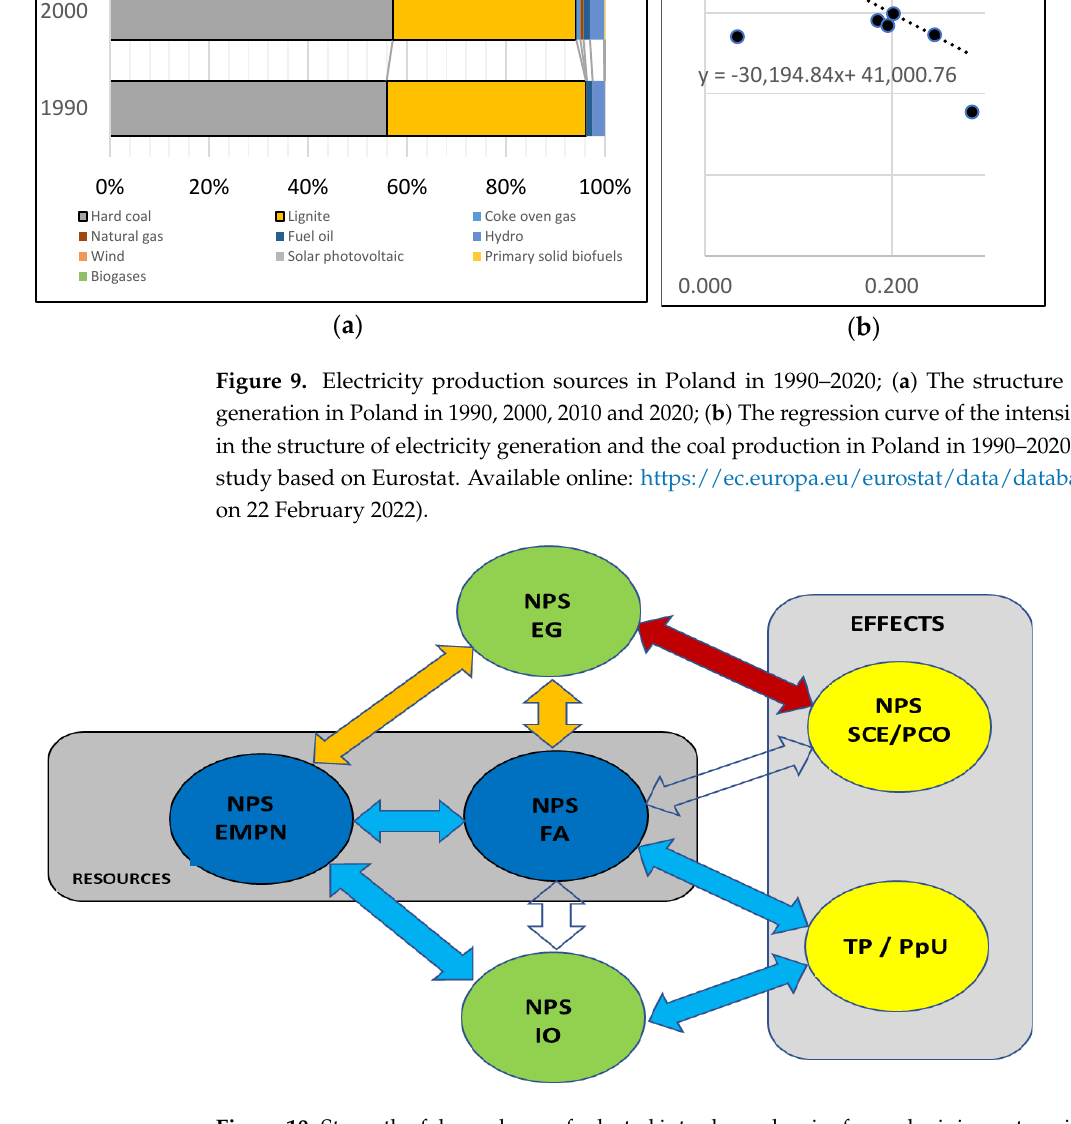
Figure 10. Strength of dependence of selected interdependencies for coal mining enterprises in Po-